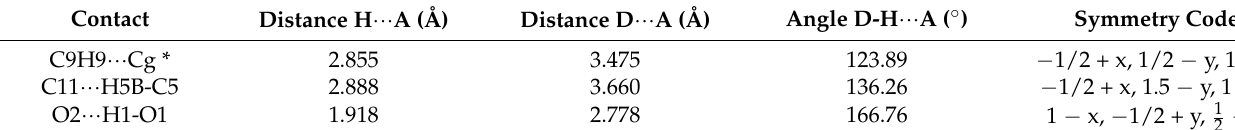
Table 3. Intermolecular interactions in compound 4b .